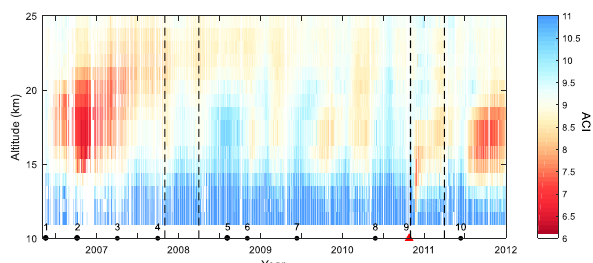
Figure A1. MIPAS 9-day running median of ACI between 10 ◦ N and 10 ◦ S from May 2006 to December 2011. The dashed vertical lines indicate the reference state from November 2007 to March 2008, and the investigation period for the Merapi eruption from November 2010 to March 2011. The red triangle indicates the time of the Merapi eruption (9). The black dots indicate (1) Soufriere Hills, (2) Tavurvur (Rabaul), (3) Piton de la Fournaise, (4) Jebel at Tair, (5) Kasatochi, (6) Dalaffilla, (7) Sarychev, (8) Pacaya and (10)